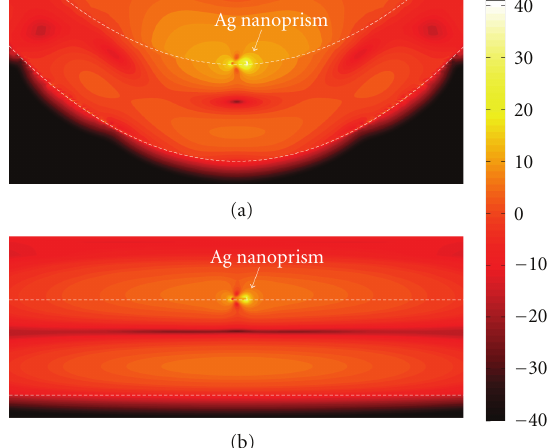
Figure 6: FDTD simulation results comparing the vertical segment electric field intensity profiles of an Ag nanoprism above (a) a parabolic reflector and (b) a planar reflector. The white dotted lines show the Au ground plane and the PMMA layer surfaces. The color map is in dB